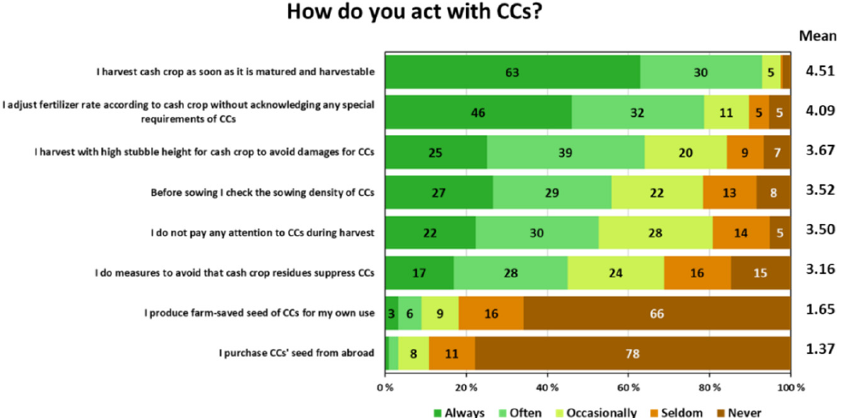
Figure 7. The distribution and mean (in order of decreasing value) of the farmers’ answers (N = 1130) to the principal question: “How often do you act with cover crops (CCs)?”. The answer choices were: “1 = never, 2 = seldom, 3 = occasionally, 4 = often and 5 = always”. The share of each answer choice (%) is shown within each bar unless it was <3%.